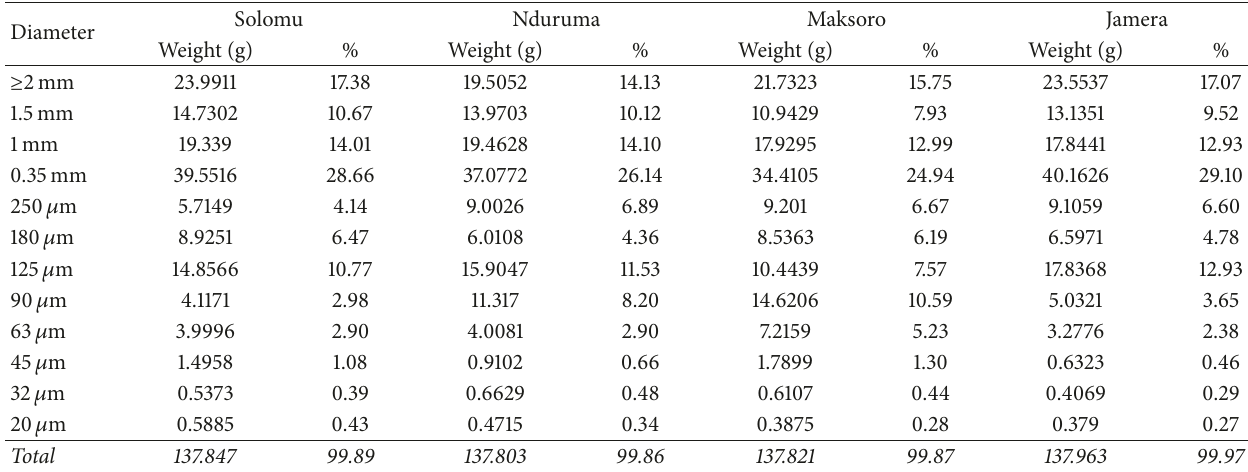
Table 5: Particle size distribution for ground igneous